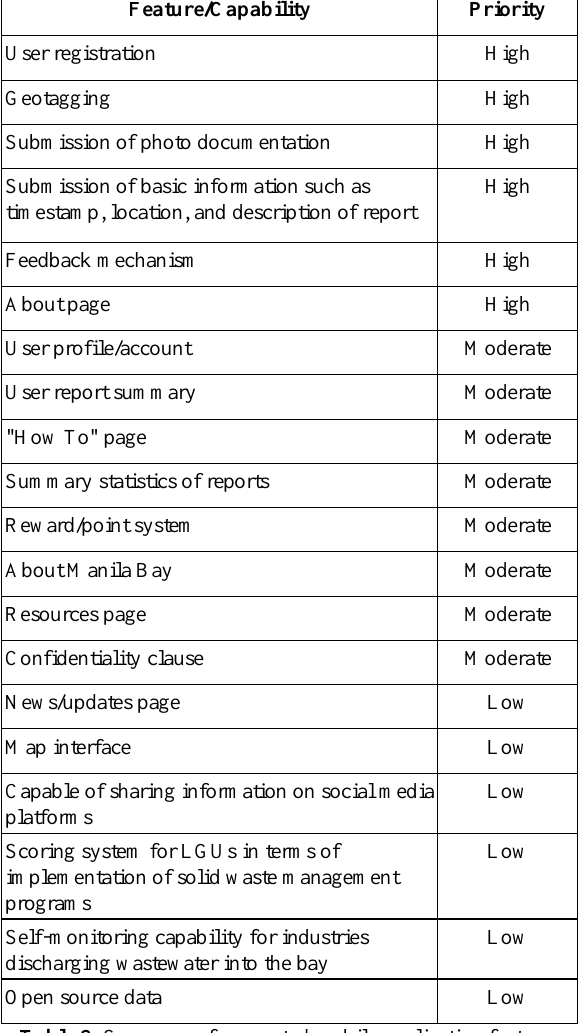
Table 2. Summary of suggested mobile application features and capabilities